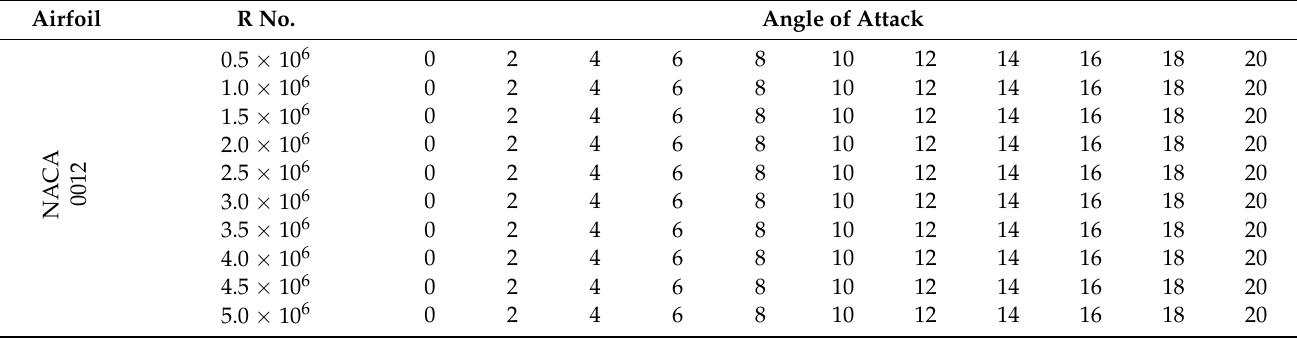
Table 1. Summary of numerically simulated flow